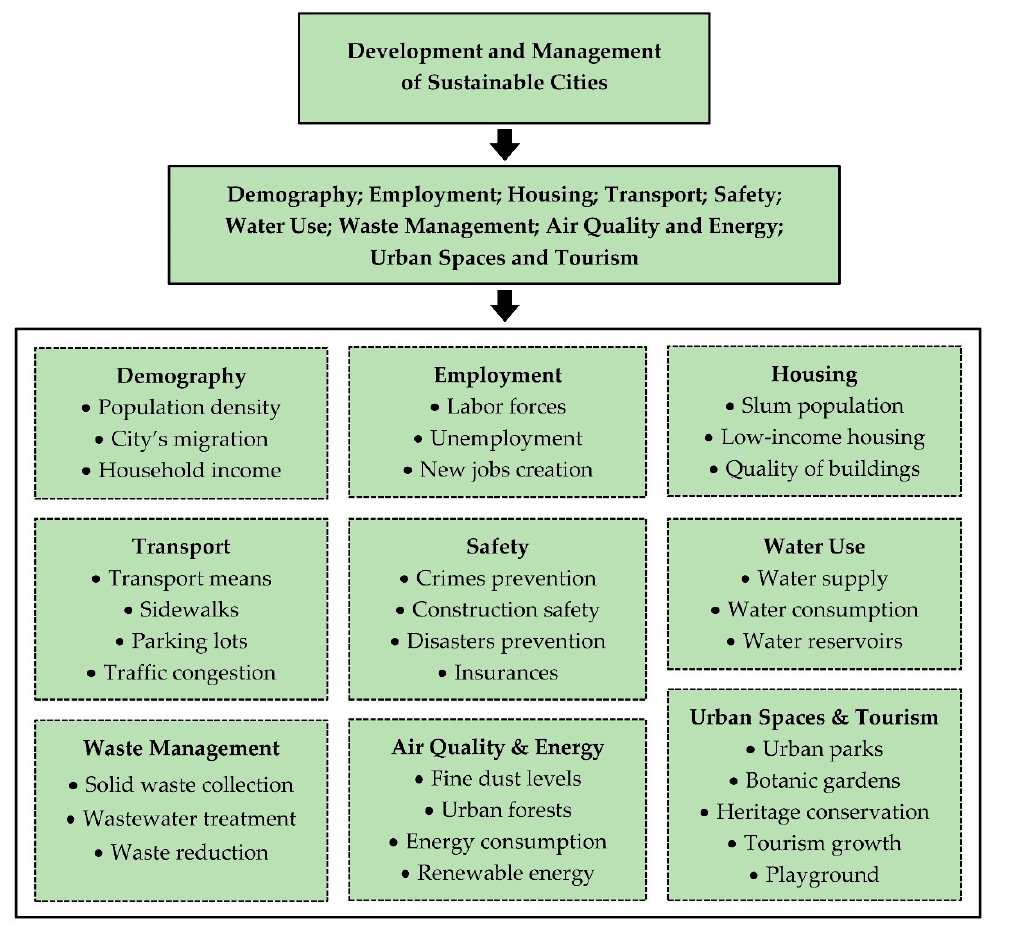
Figure 1. The nine criteria and their assessment indicators for AHP surveys.